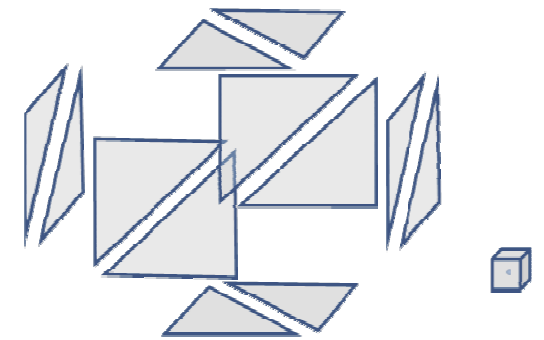
Figure 5. Polyhedron-inner side evaluation decomposition